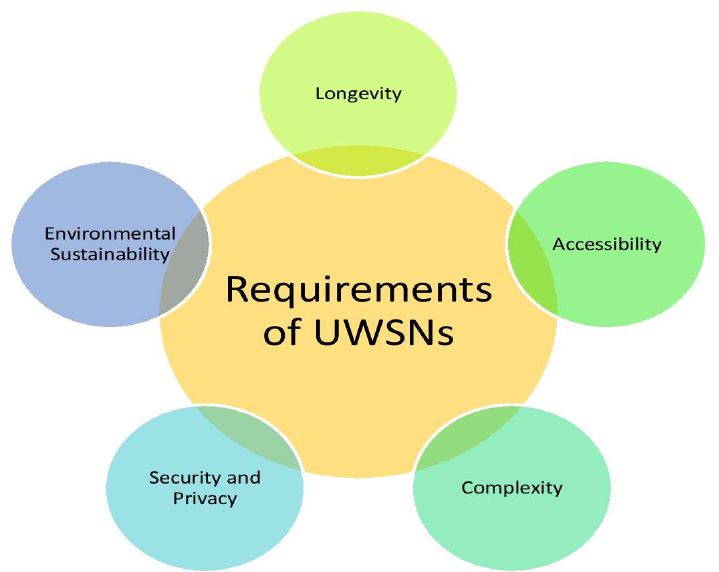
Figure 4. Requirements of